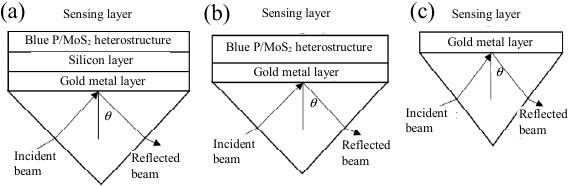
Fig. 1 Schematic diagram of a proposed SPR sensor configuration: (a) blue P/MoS 2 hetero-structure with the silicon layer SPR sensor, i.e., structure-I, (b) blue P/MoS 2 hetero-structure based SPR sensor, i.e., structure-II, and (c) conventional SPR sensor, i.e.,